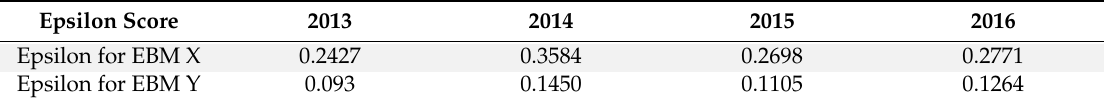
Table 2. Epsilon score. EBM—Epsilou-based Table 2. . Epsilon score. EBM—Epsilou-based measure.